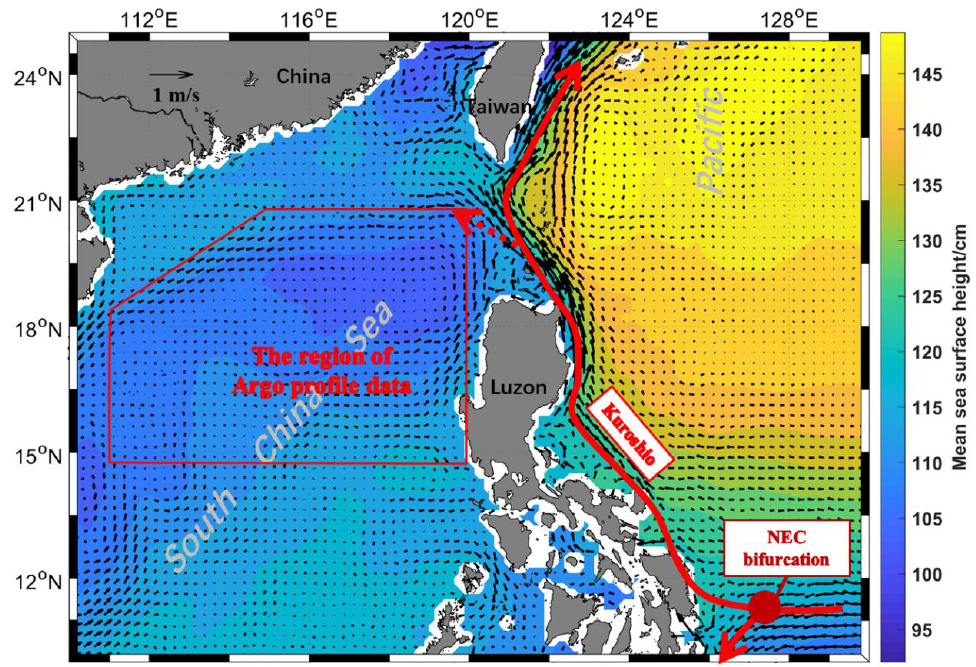
Figure 1. Mean sea surface height (SSH) (cm) and the corresponding surface geostrophic currents (m s − 1 ) derived from 25-year (1993–2018) satellite altimeter data. Red solid lines represent a schematic of the current system. Red box is the research area of Argo profile data. NEC bifurcation is the bifurcation of the North Equatorial Current